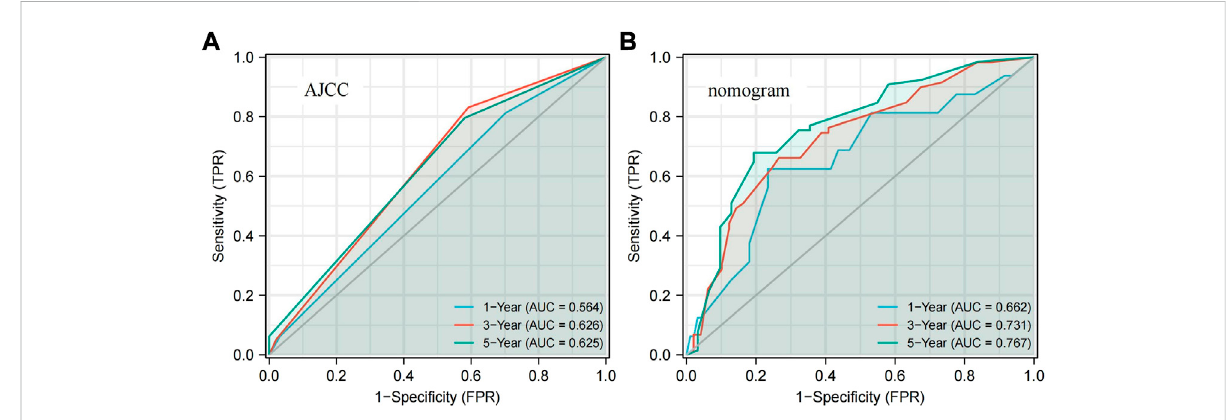
FIGURE3 ROC curves present the predictive power for 1-year, 3-year, and 5-year OS. (A) AJCC stage. (B) Nomogram. ROC: receiver operator characteristic; AJCC: American Joint Committee on